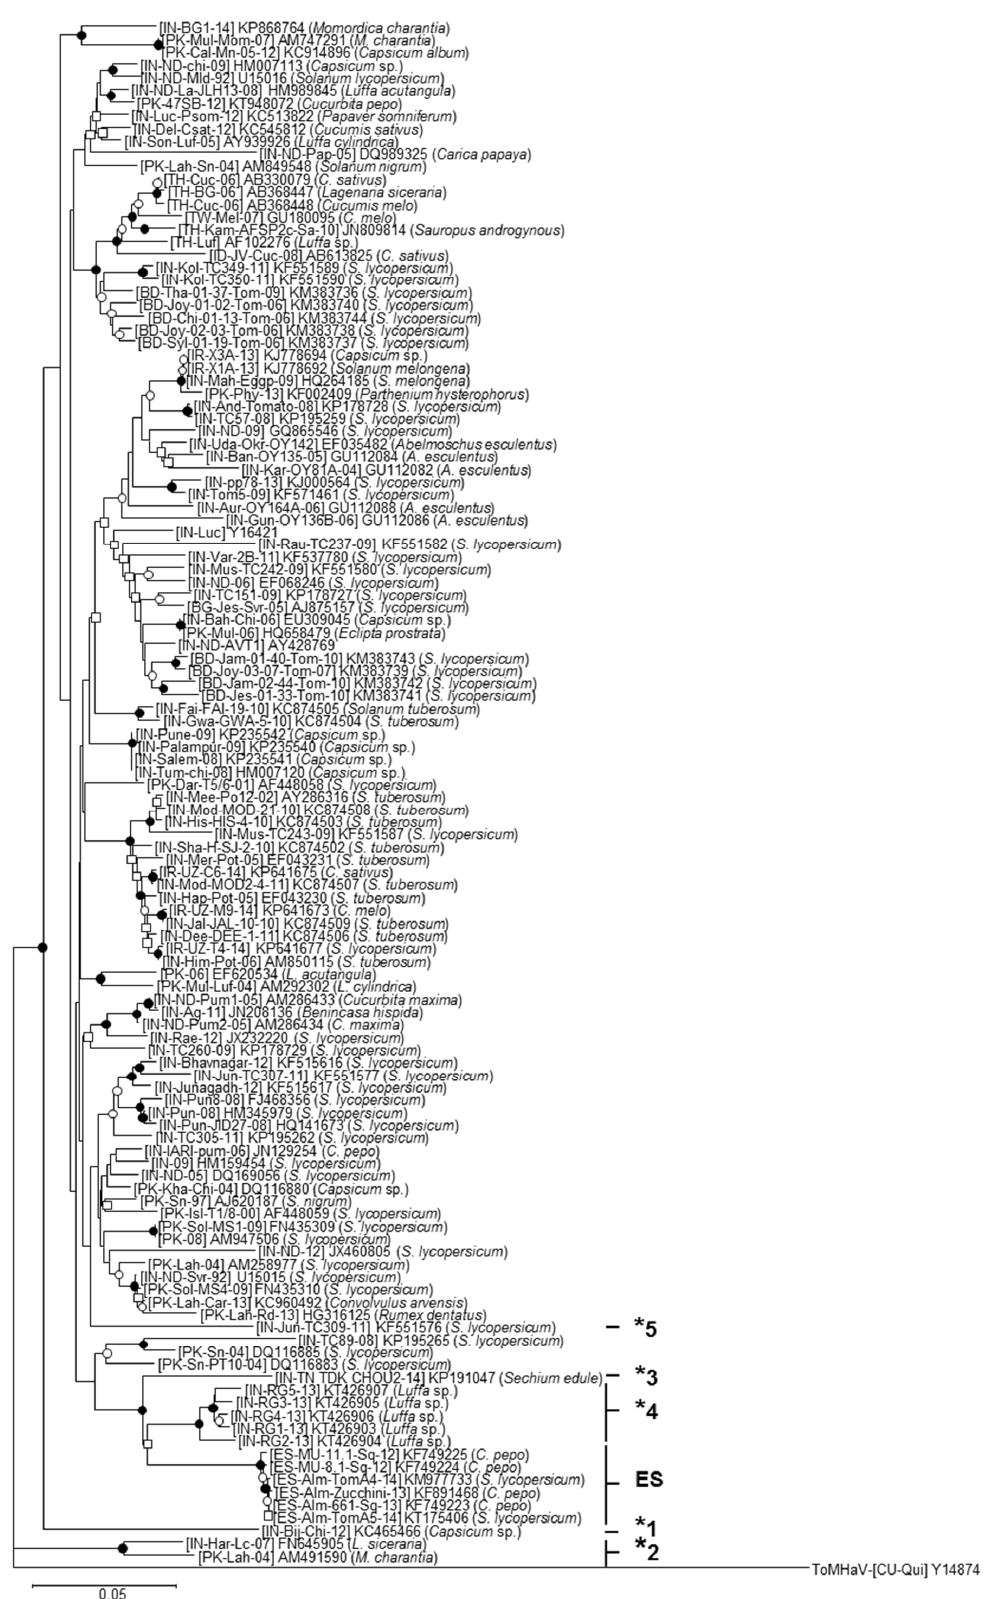
Figure 3. Phylogenetic relationships among DNA-A sequences of ToLCNDV isolates. Phylogenetic relationships among the full-length DNA-A sequences of 126 tomato leaf curl New Delhi virus (ToLCNDV) isolates available in the NCBI-GenBank and International Committee on Taxonomy